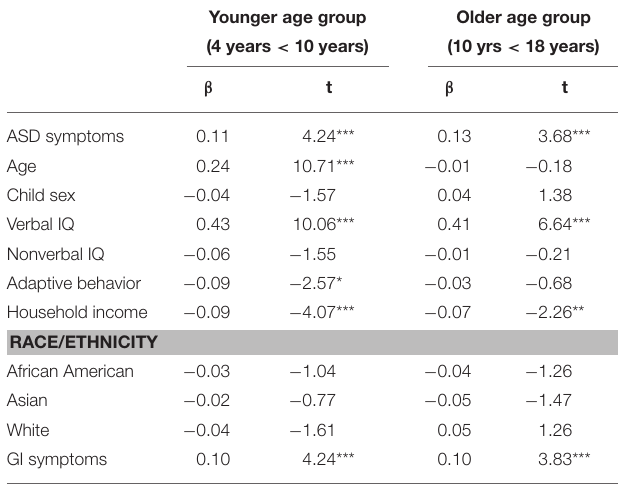
TABLE 3 | Unique contributions of child and family factors to internalizing